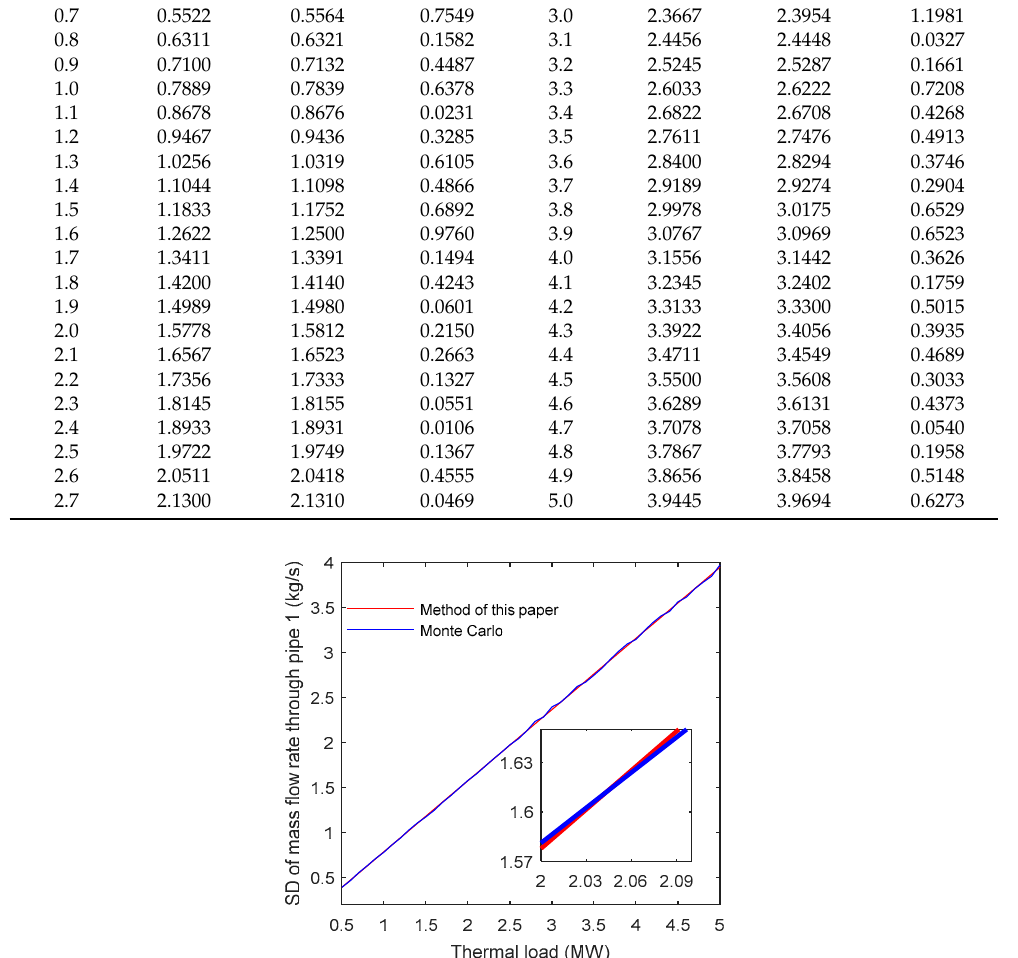
Figure 10. The standard deviations of mass flow rate through pipe 1 using the Monte Carlo method and the proposed analytical method with respect to average thermal load ( σ ϕ = ± 10%).